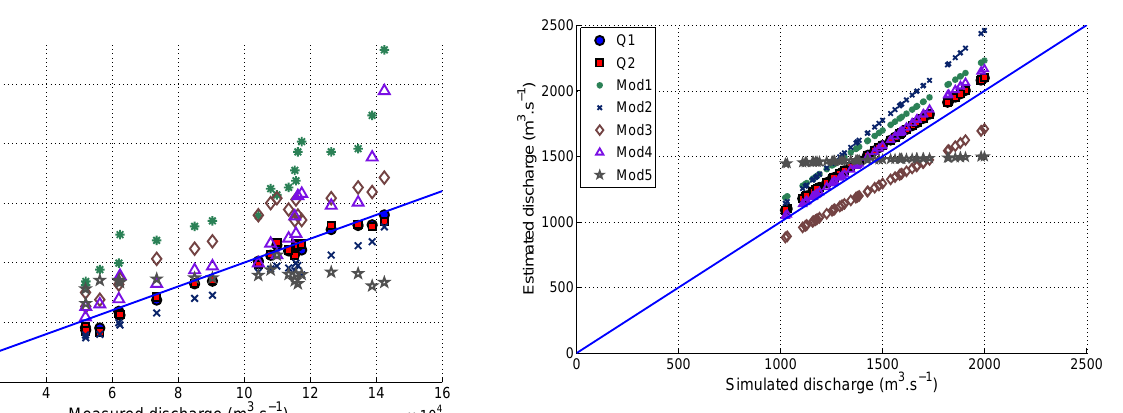
Fig. 6. Comparison of the estimated discharge with simulated dis- charge